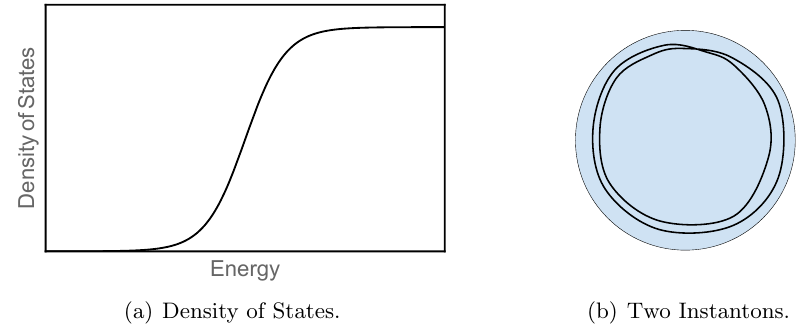
Figure 2 . Density of States and the Two Instantons